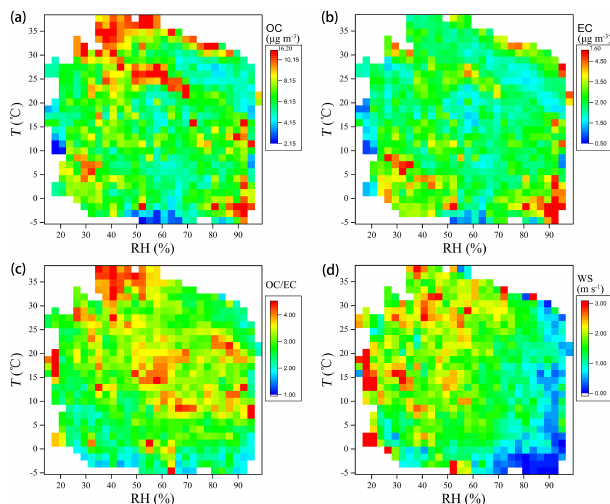
Figure 12. RH– T dependence of (a) OC mass concentrations, (b) EC mass concentrations, (c) OC / EC ratios, and (d) wind speeds (WS) between July 2010 and December 2014 in Shanghai. The data are grouped into 900 (30 × 30) grids, with increments of RH and T being 2.86% and 1.46 ◦ ,